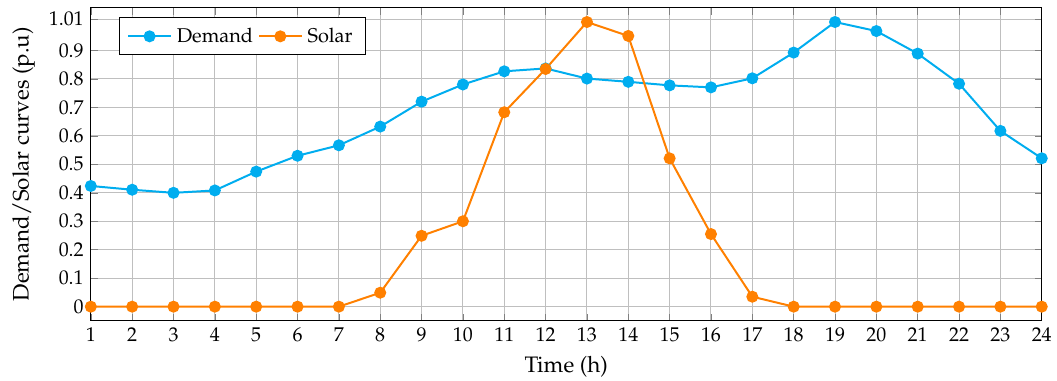
Figure 6. Daily behavior of the load and renewable generation.